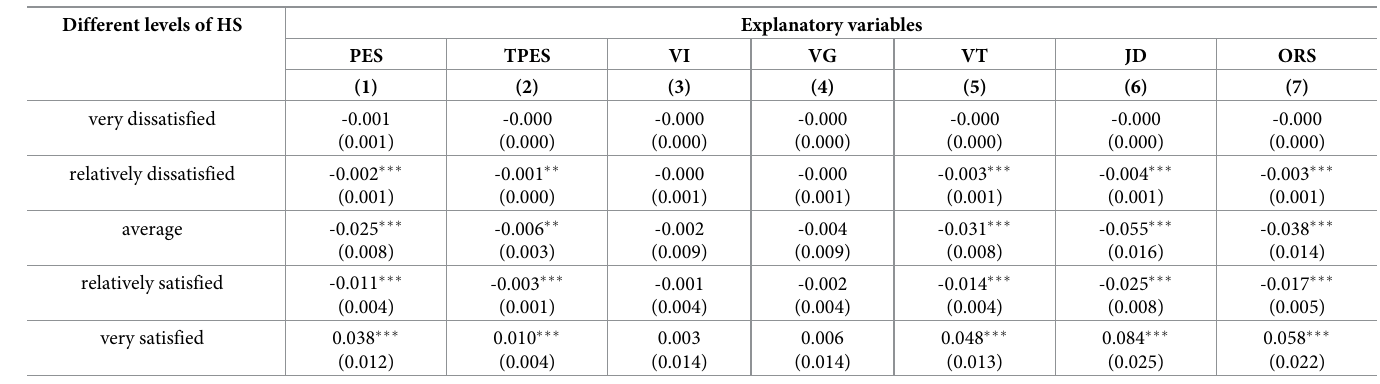
Table 3. Marginal effects of public employment services on self-rated health.